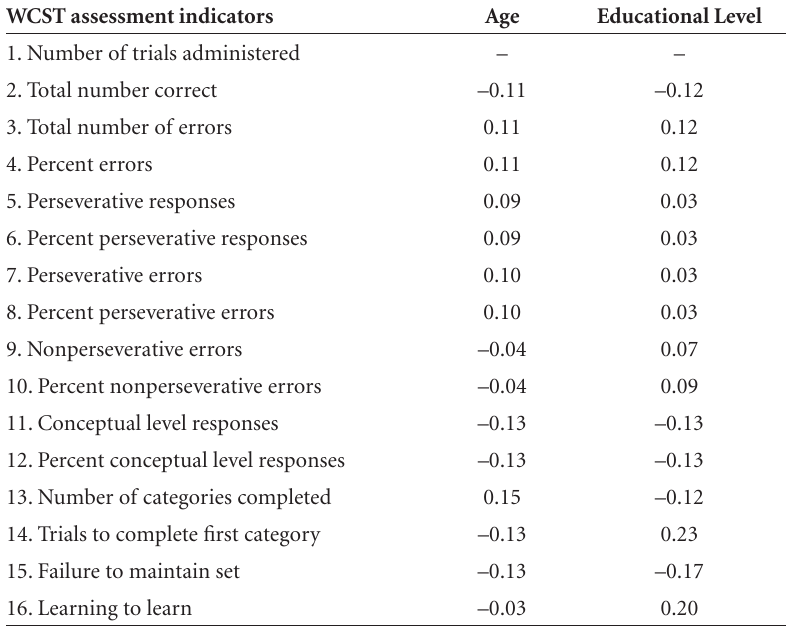
Table 4. Pearson correlation indexes for performance on the WCST in elderly AD patients (n=36), considering age and educational